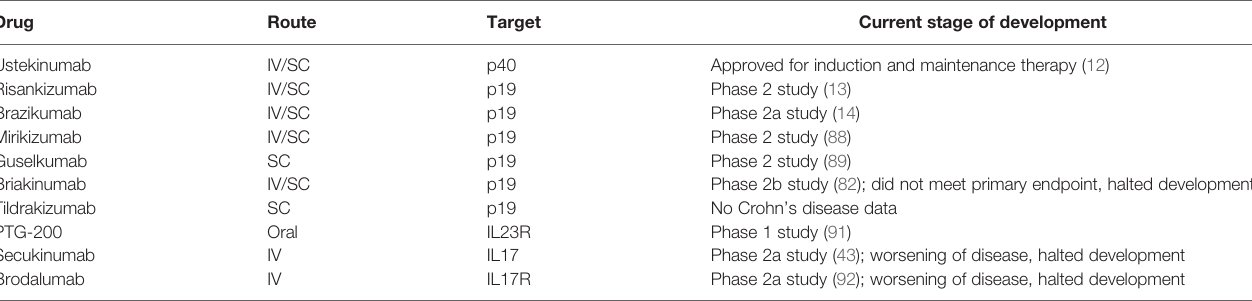
TABLE 1 | Targeted therapies directed against IL12, IL17, IL23 or their respective receptors. Drug Route Target Current stage of development